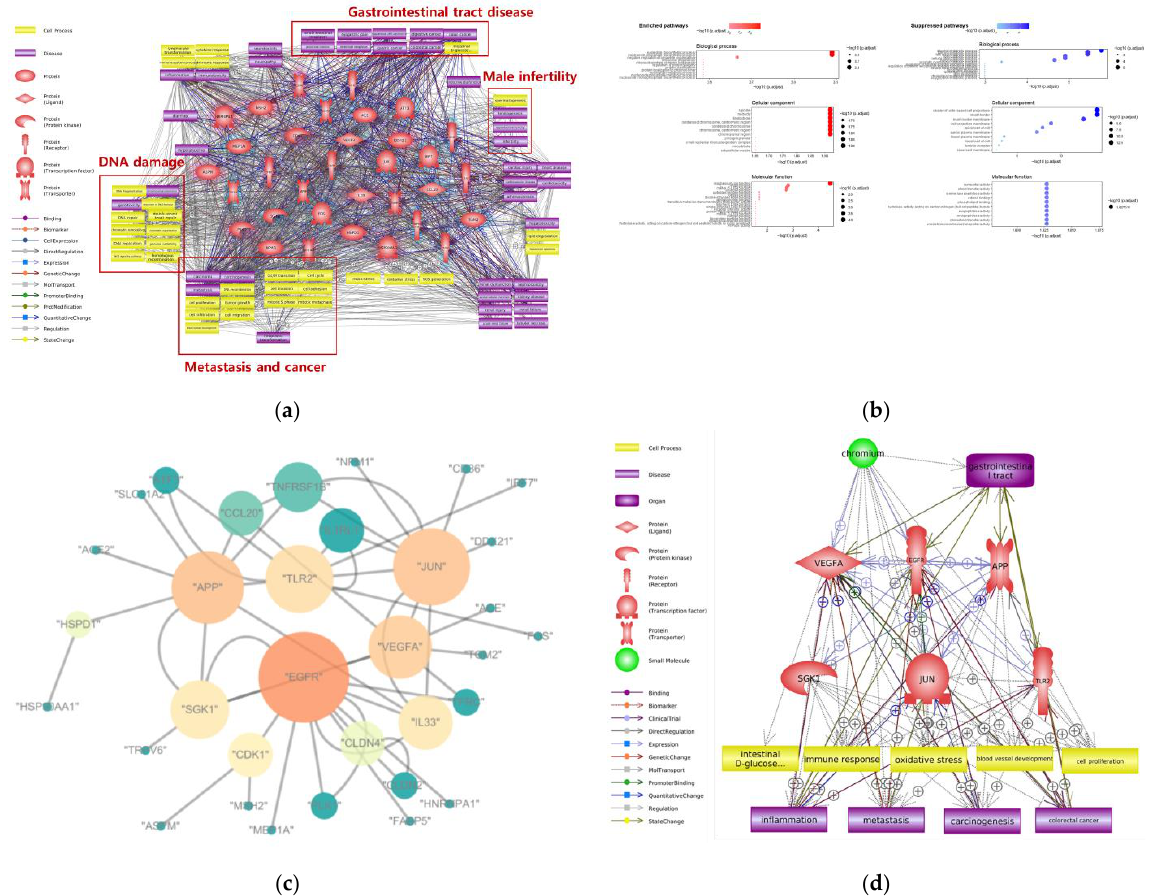
Figure 4. Bioinformatic analysis about Cr toxicity on gastrointestinal tract. ( a ) molecular network includes genes, cell processes, diseases about Cr ingestion; potential toxicity mechanism highlighted with red colored box. ( b ) Enriched and Suppressed biological processes, cellular components, molecular functions associated with Cr ingestion. ( c ) Gene – gene interaction network following Cr ingestion; each node’s color represents betweenness centrality, and each node’s size represents the degree of the nodes; ( d ) Summarized molecular network and hub genes about Cr ingestion.